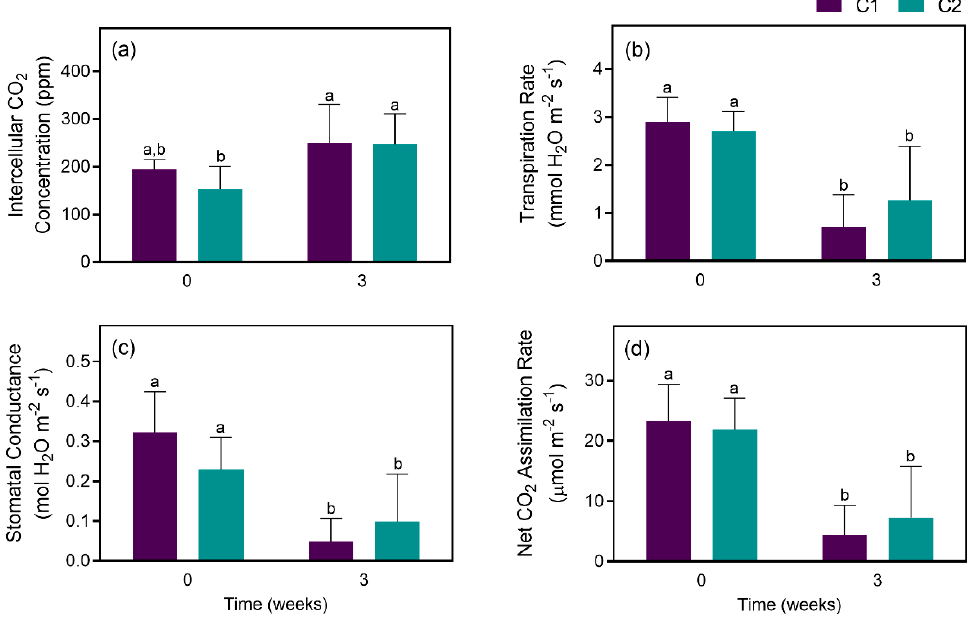
Figure 8. Gas exchange-related parameters of hybrid plants from populations C1 and C2 on t0 (plants watered to full field capacity) and t3 (3 weeks under water deficit): ( a ) intercellular CO 2 concentration; ( b ) transpiration rate; ( c ) stomatal conductance; ( d ) net CO 2 assimilation rate (D). Values are means ± SDs, n = 13 , different letters indicate significant differences between treatments at p ≤ 0.05.